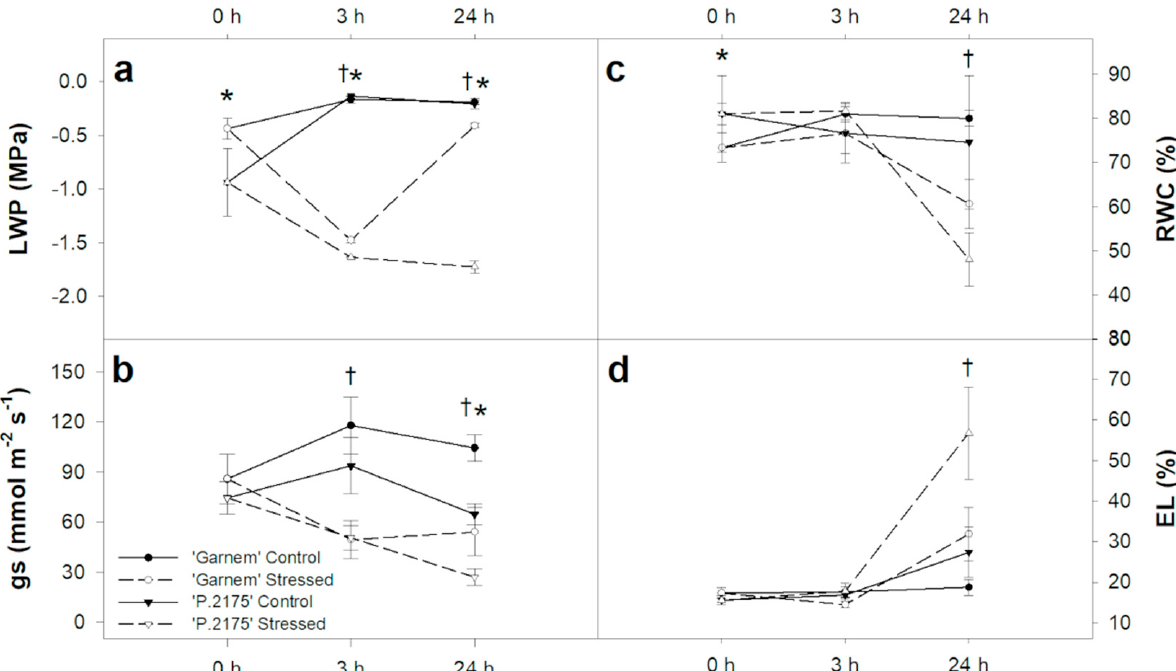
Figure 3. Evolution of ( a ) leaf water potential (LWP); ( b ) stomatal conductance (gs); ( c ) relative water content (RWC); and ( d ) electrolyte leakage (EL) during the drought experiment. Error bars represent the standard error of the mean. *: significant differences ( p ≤ 0.05) following the Student’s t -test between genotypes (‘Garnem’ vs. Myrobalan ‘P.2175’) for each time point (0 h–3 h–24 h) and for each treatment (control vs. tressed) of the experiment; †: significant differences ( p ≤ 0.05) following the Student’s t -test between treatments (control vs. drought stress) for each time point of the experiment. h = hour.